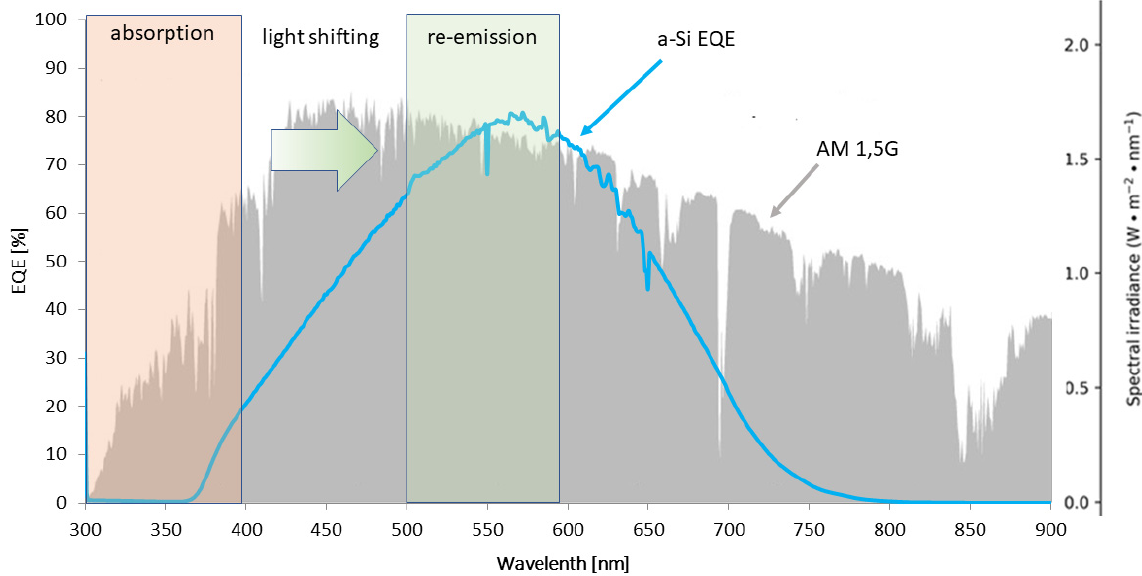
Figure 1. General idea of down-shifting process flow in an amorphous silicon solar cell. The ultraviolet range of the solar irradiation spectrum is not used by a silicon solar cell efficiently, hence the DS layer is shifting radiation to the range, which is effectively matched to a specific solar cell quantum efficiency [22].